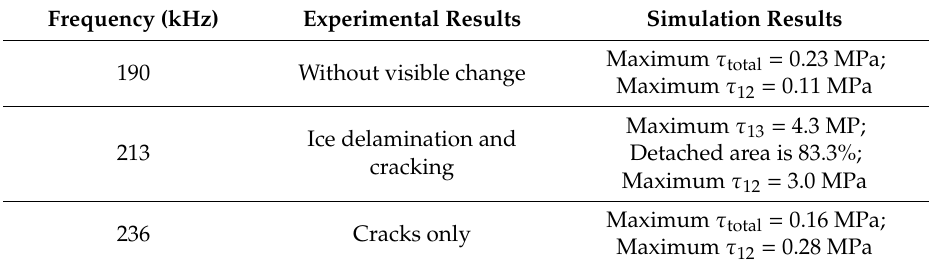
Table 4. Comparison of experimental and simulation results for three different frequencies.